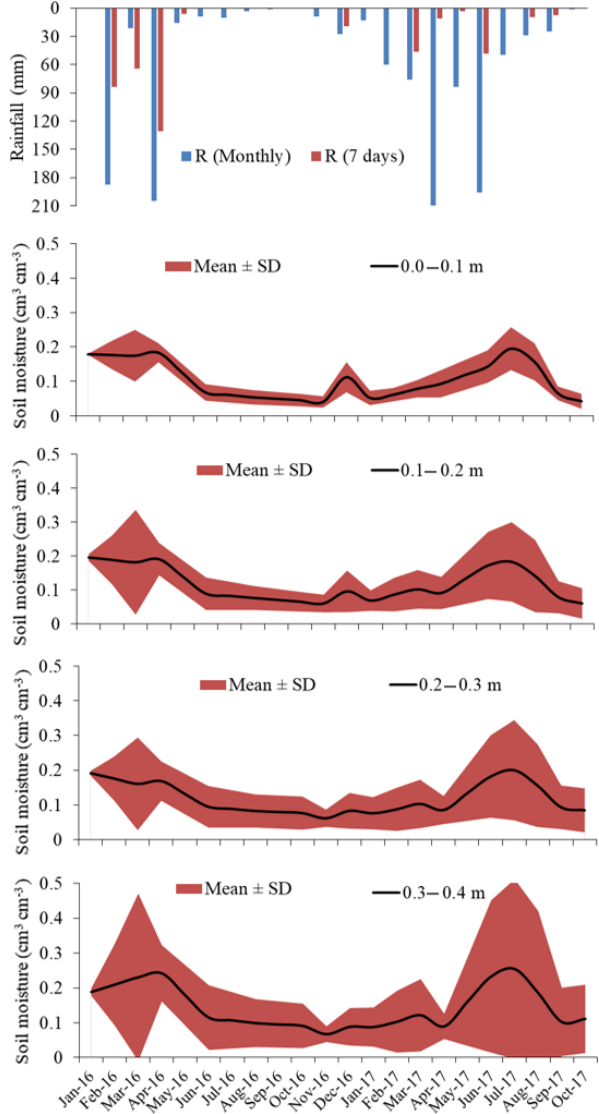
Figure 6. Time series for the mean soil moisture, for native vege- tation (Caatinga), for the 0–0.10, 0.10–20, 0.20–0.30, 0.30–0.40m layers. It is also presented the one standard deviation interval around the mean